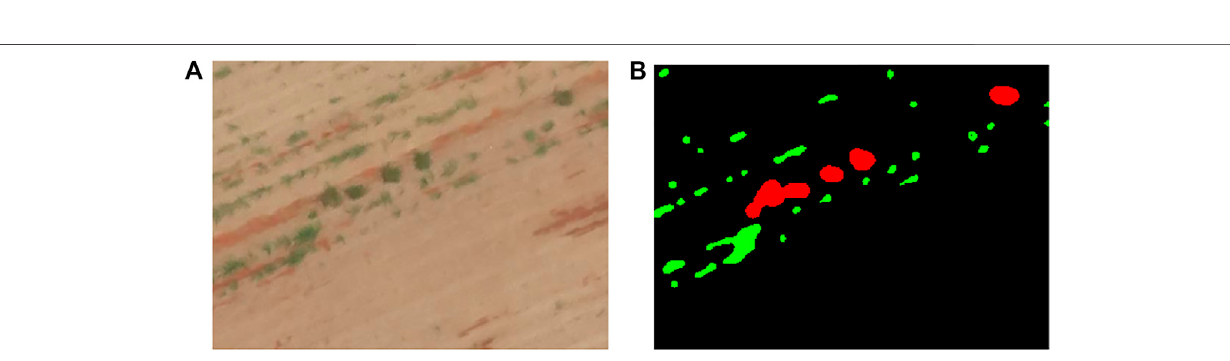
Frontiers in Remote Sensing |